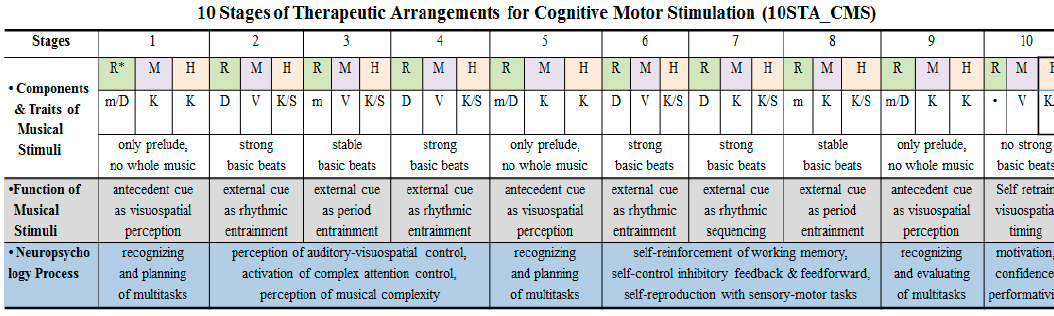
Figure 4. Therapeutic process and functions of 10STA_CMS based on modulated rhythm, melody, and harmony. This figure includes musical traits, functions, and the specific neurocognitive process of musical stimuli as external cues with therapeutic musical devices.